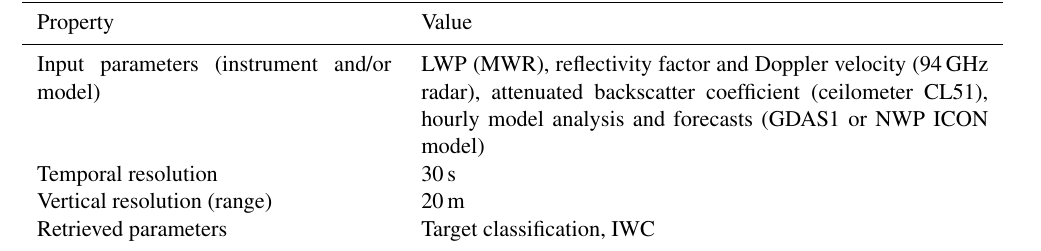
Table 2. Cloudnet characteristics for